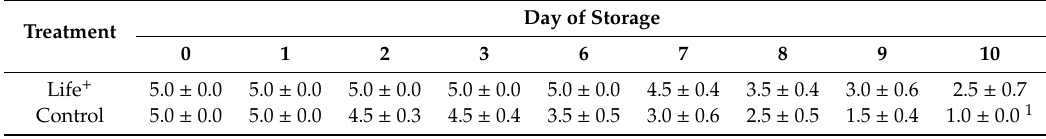
Table 8. Visual quality evaluation of strawberries stored at 6 ◦ C for 10